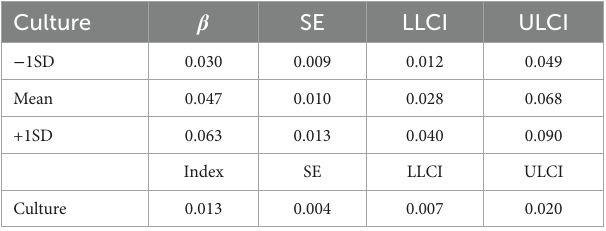
TABLE 10 Bootstrap confidence interval estimation results of moderated mediating effect: specific conditional values of culture and the index of moderated